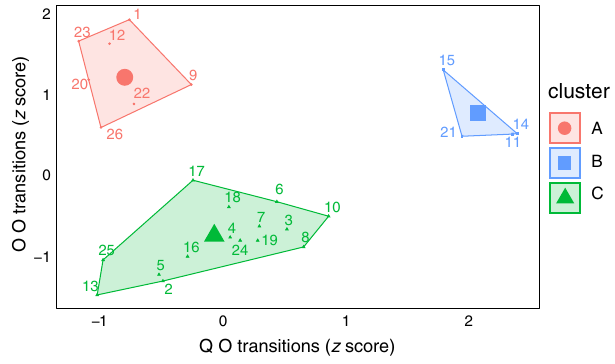
FIG. 3. Characterization of the three clusters emerging from cluster analyses based on eye movement transition measures during problem solving.